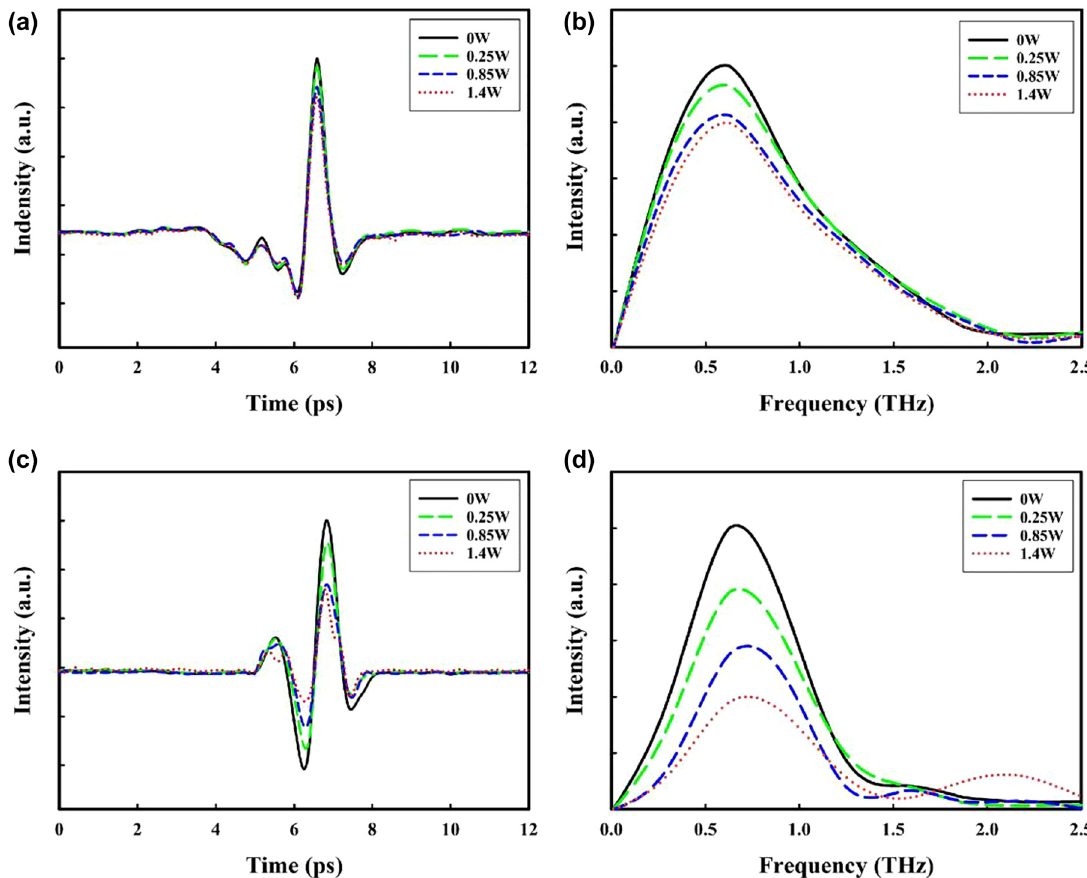
Figure 3: Transmitted THz electric fields of the devices.